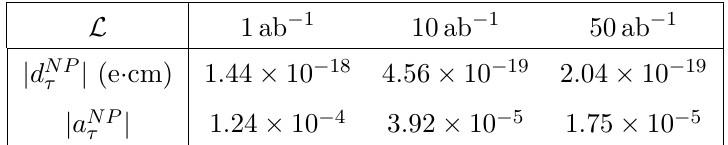
(right), where the statistical error bars (cid:28)